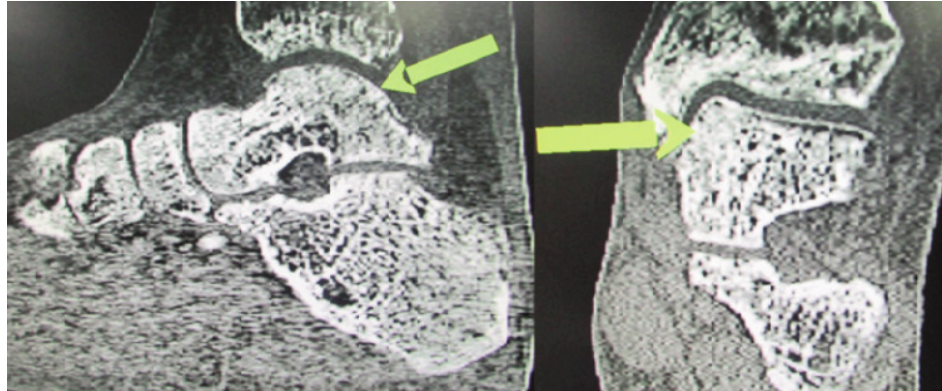
CT scan images showing healing of the subchondral cyst (Arrows- healed areas of subchondral cyst). Fig. 3: